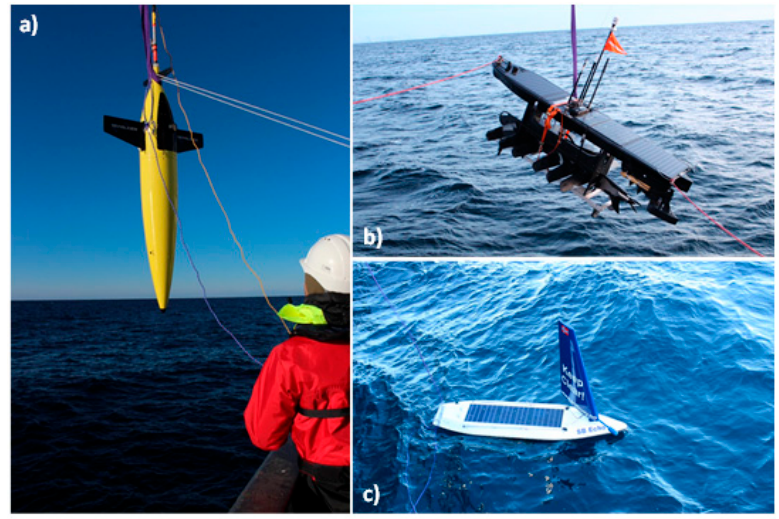
Figure 1. Surface and subsurface platforms employed in the GLIDER project: ( a ) Seaglider ® (Huntington Ingalls Industries; formerly Kongsberg Maritime); ( b ) Wave Glider SV3 (Liquid Robotics); and ( c ) Sailbuoy (Offshore Sensing).